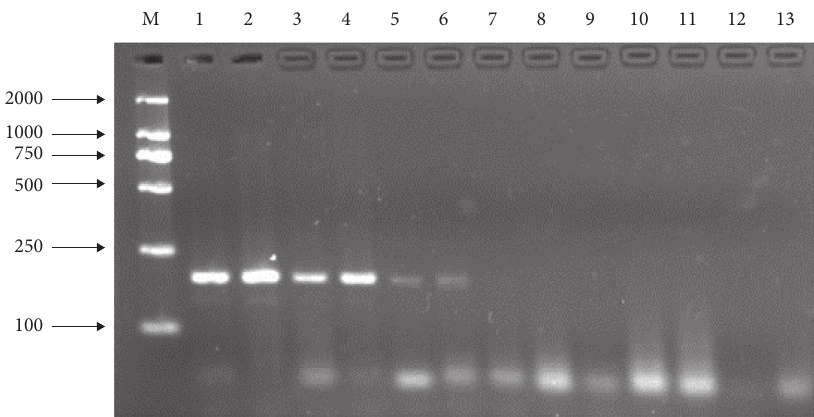
Figure 4: The detection sensitivity of the spt5 gene detection in qualitative PCR. The initial amount of DNA in each PCR reaction is as follows: 1-2, 40ng; 3-4, 4ng; 5-6, 0.4ng; 7-8, 0.04ng; 9-10, 0.004ng; 11-12, 0.0004ng; 13, negative control; M DNA marker DL 2000.